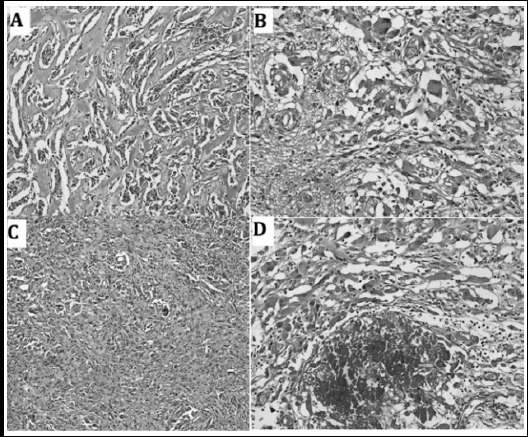
Hematoxylin and Eosin stained sections at medium power show pleomorphic cells with giant cells (A&B). Spindling of the tumor cells (C) and Calcification (D) can also be seen.